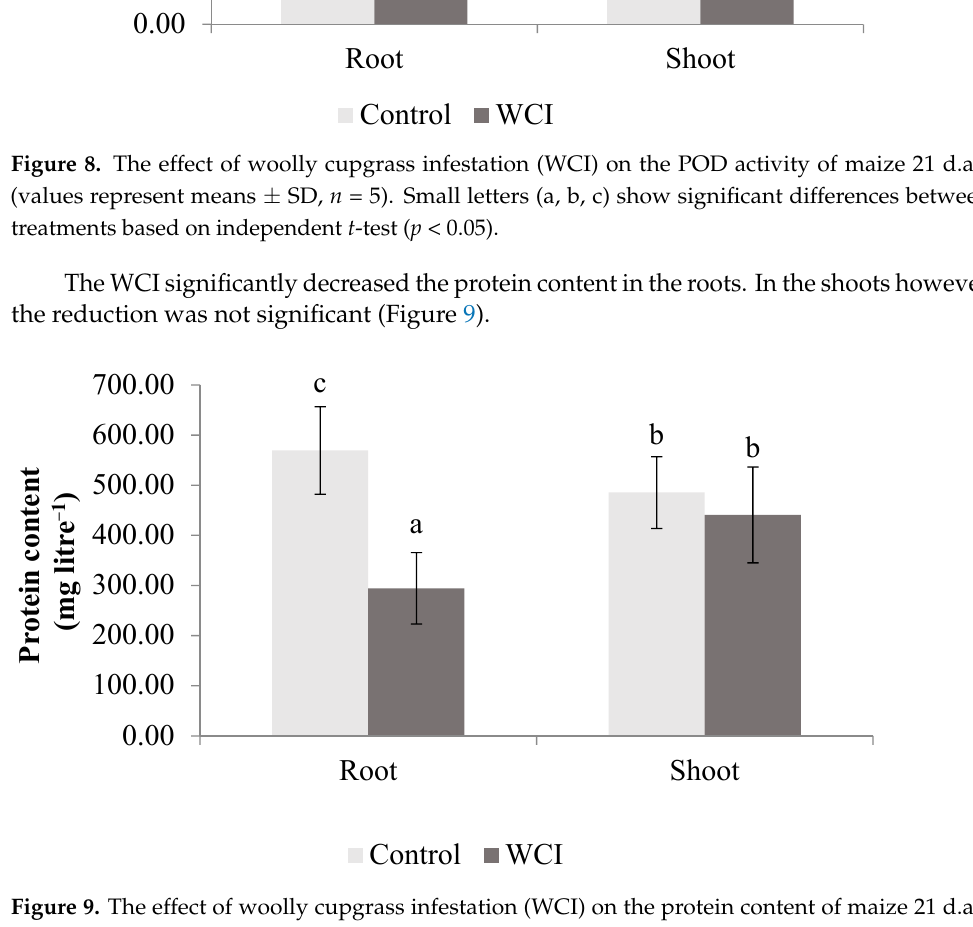
Figure 9. The effect of woolly cupgrass infestation (WCI) on the protein content of maize 21 d.a.s. (values represent means ± SD, n = 5). Small letters (a, b, c) show significant differences between treatments based on independent t -test ( p < 0.05).